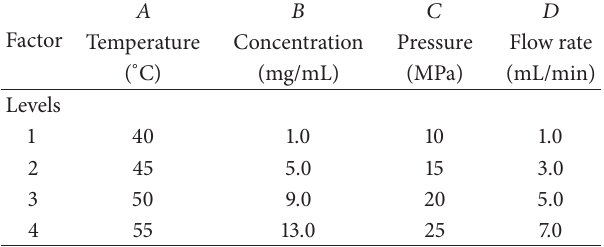
Figure 1: Chemical structure of Res (molecular formula: C 14 H 12 O 3 ; molecular weight: 228.25).